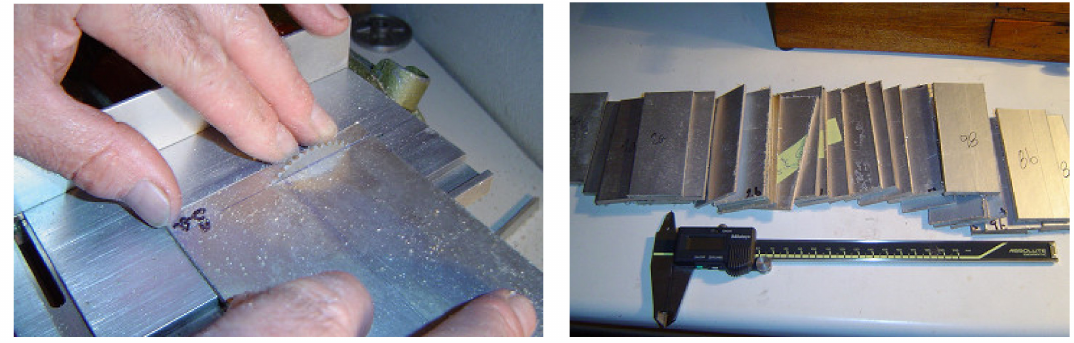
Figure 4. Operations performed to obtain the parts (boards of laminate composite material).